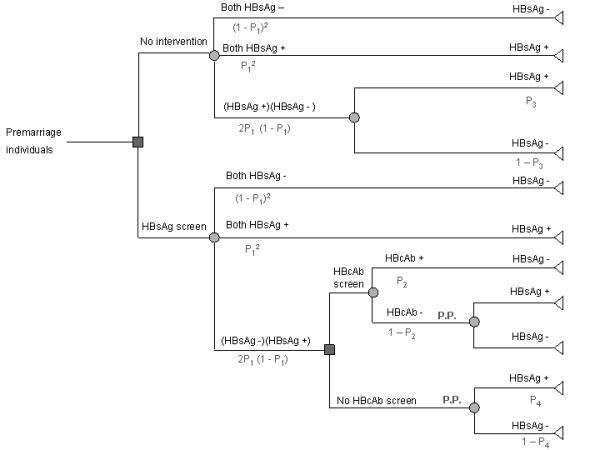
The decision tree model for premarriage prevention of HBV sexual transmission. Two similar intervention strategies start with HBsAg screening of all premarriage individuals. HBsAg negative individuals whose would-be spouse is HBsAg positive are considered for further intervention. Strategy 2 contains additional screening for HBcAb and applying the preventive protocol (P.P.) -see text- only to those negative for HBcAb (assumed to be serosusceptible) whereas in strategy 1, no HBcAb screening occurs and the prevention protocol (P.P.) is immediately performed. Only important probabilities are depicted in the figure. P1, P2, P3, P4 are defined in Table 1. P.P. stands for the preventive protocol explained in methods section in text.